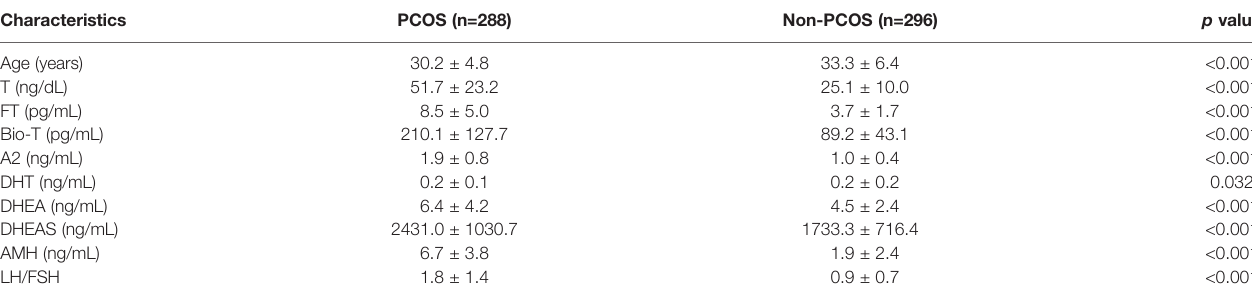
TABLE 1 | The age, androgens, AMH and LH/FSH ratio of women in the PCOS and the non-PCOS group.